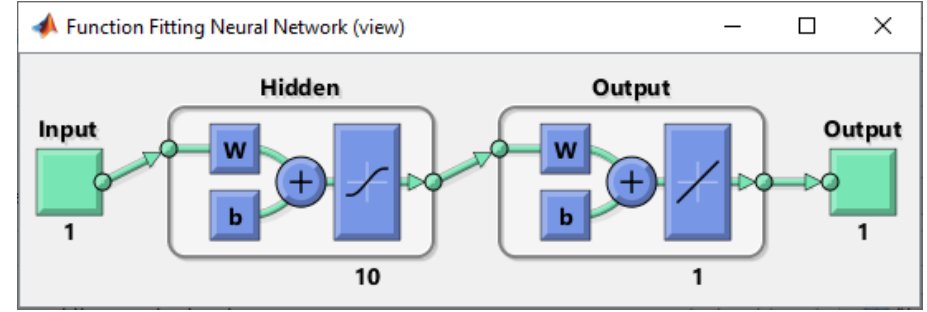
Figure 6. Scheme of the fitting neural network [authors’ own processing].